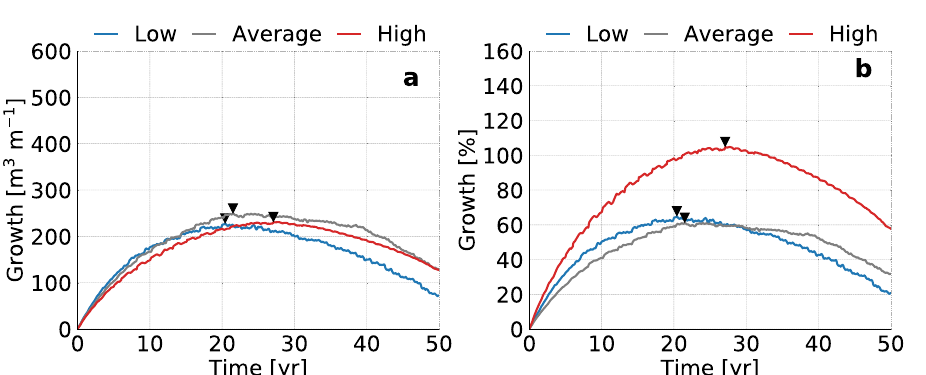
Figure 8. Simulated growth of fresh groundwater for low (blue line), average (dark grey line), and high (red line) estimates of the global slope of the nourished beach in sandy shores, where the black triangles point to the time with the maximum growth of fresh groundwater. The graphs represent the change in volume (left) and percentage (right) with respect to the initial conditions (i.e. equal to equilibrium state without beach nourishment).